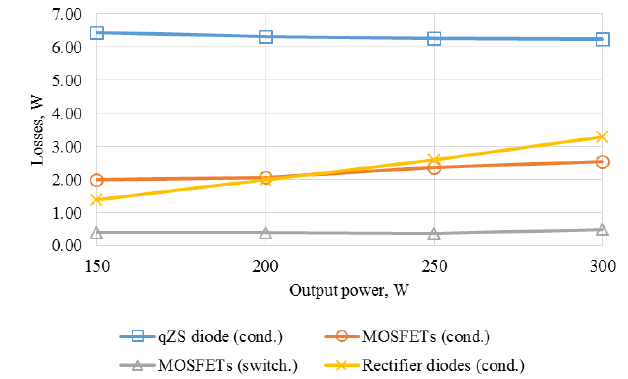
Fig. 7. Semiconductor power losses versus output power in the qZS converter.